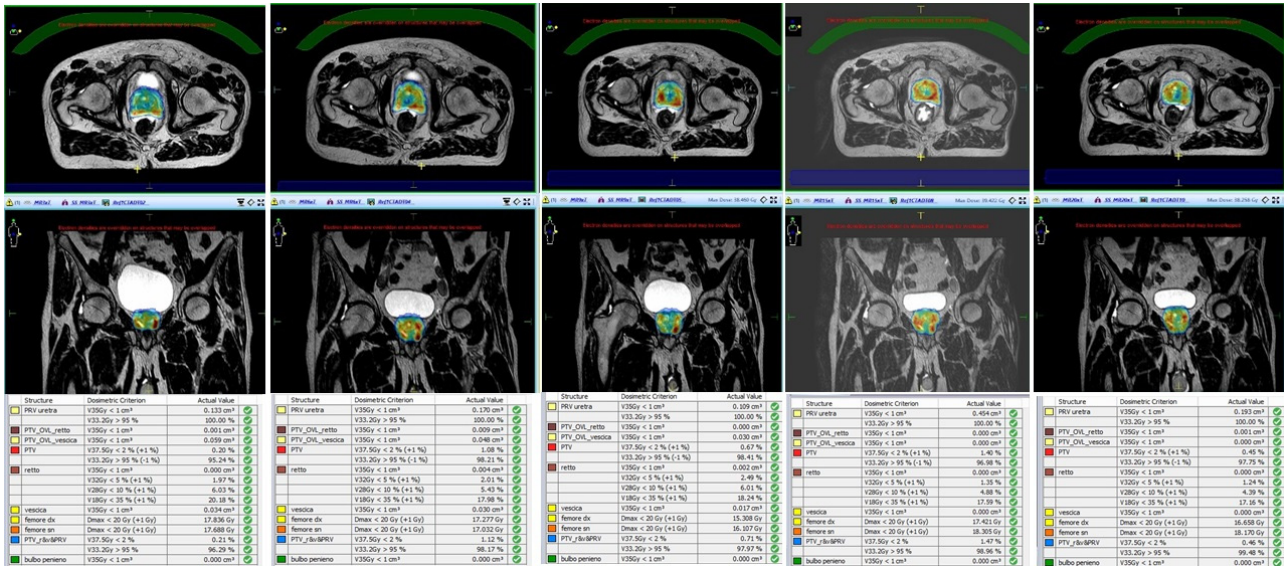
Figure 1. Daily replanning for Magnetic Resonance-guided Stereotactic Body Radiotherapy (MR-guided SBRT).